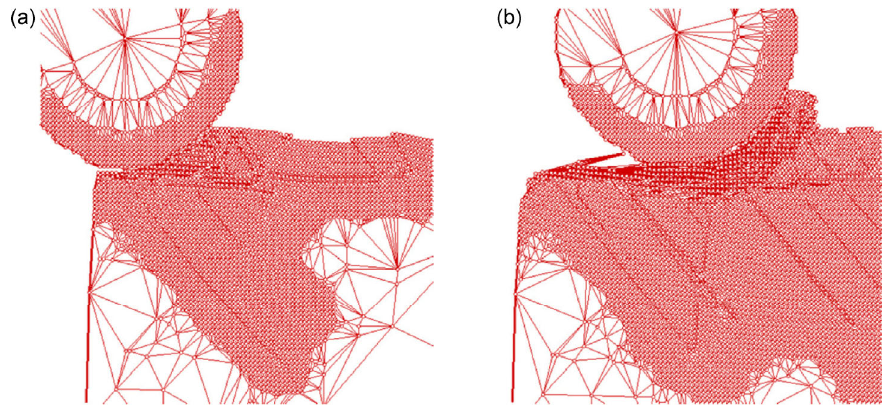
Fig. 6 Abrasive particle with radius of 5 nm at (a) 50 th time step, and (b) 200 th time step.